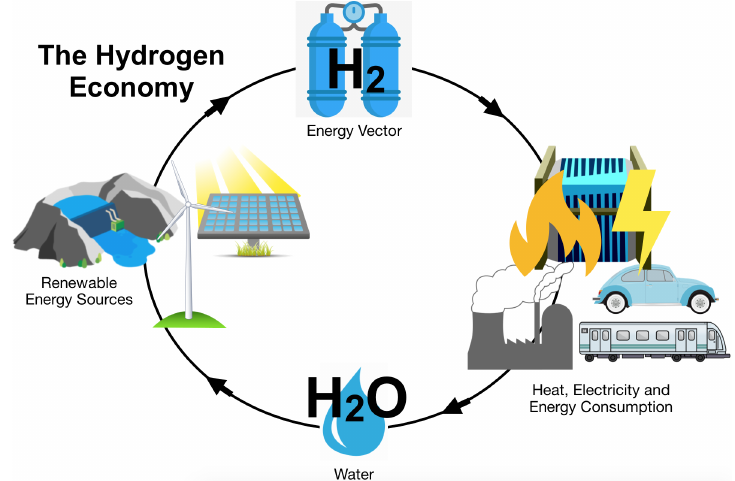
Figure 1. Schematic overview of a hydrogen based energy